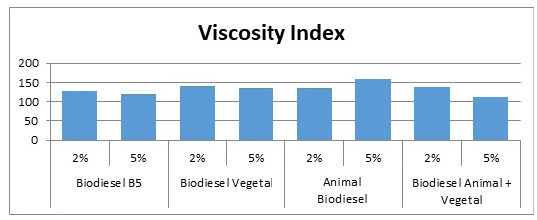
Figure 5. Comparison of viscosity indexes.